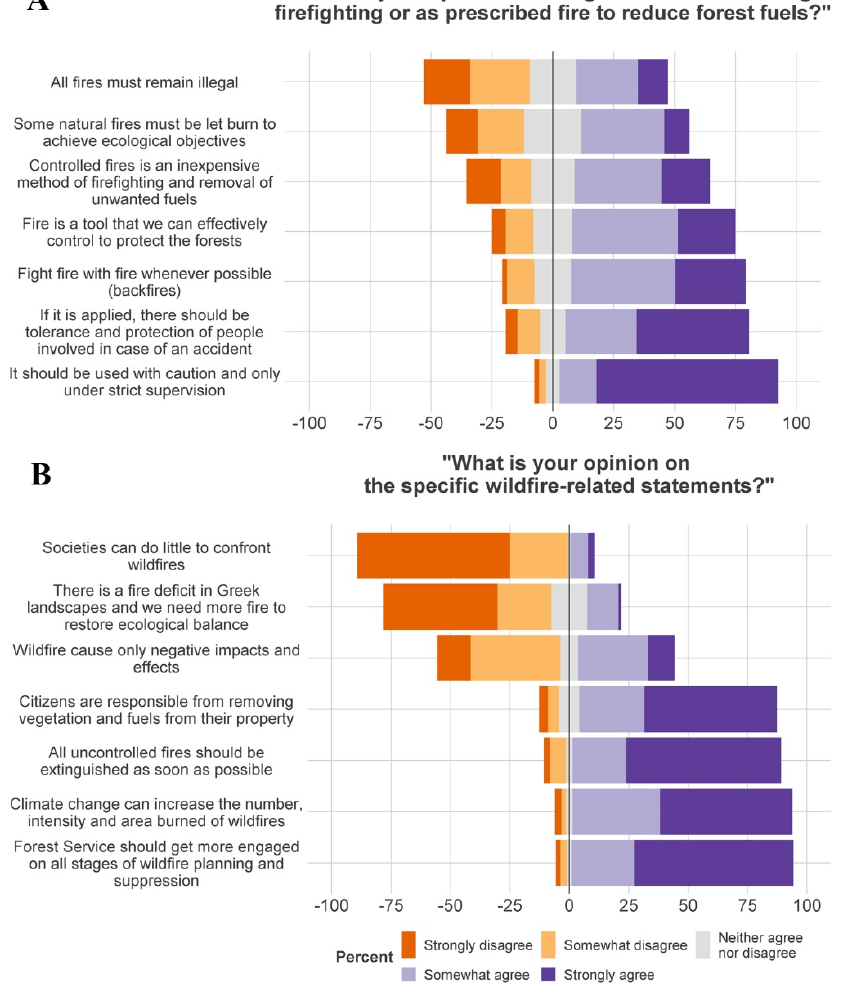
Figure 3. Likert scale responses for two of the six general survey questions regarding fire management. ( A ) What is your opinion on using controlled fire during firefighting or as prescribed fire to reduce forest fuels? ( B ) What is your opinion on the specific wildfire-related statements?